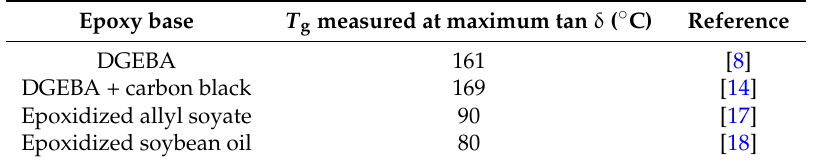
Table 1. Glass transition values of epoxy based thermosets measured at maximum of tan δ .